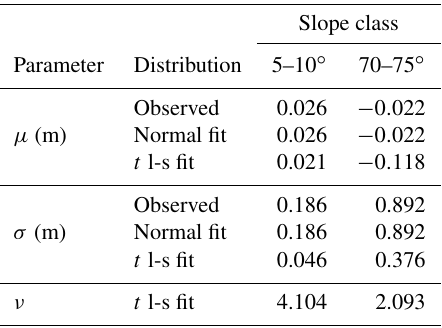
Table 6. Observed (calculated under Gaussian assumption) and fit- ted normal and t location-scale ( t l-s) parameters for the residual distributions shown in Fig.